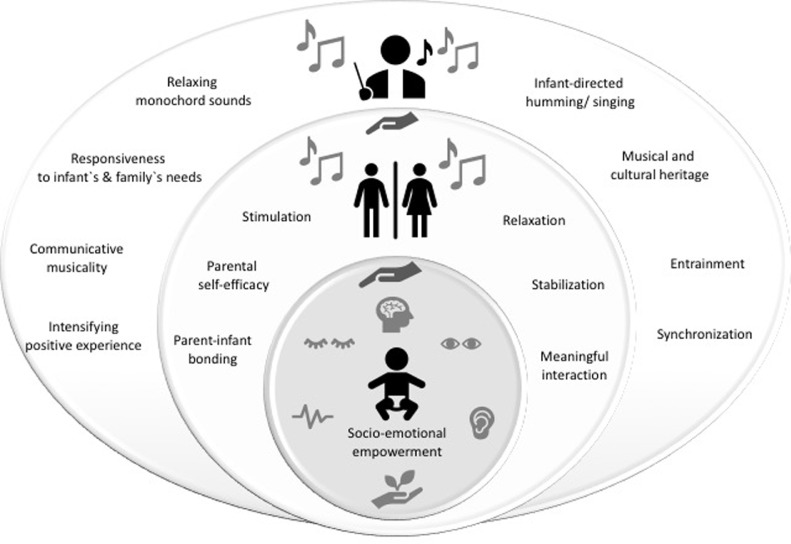
Creative Music Therapy with preterm infants and their parents. Responsiveness, communicative musicality, and empowerment via infant-directed humming/ singing and relaxing monochord sounds.